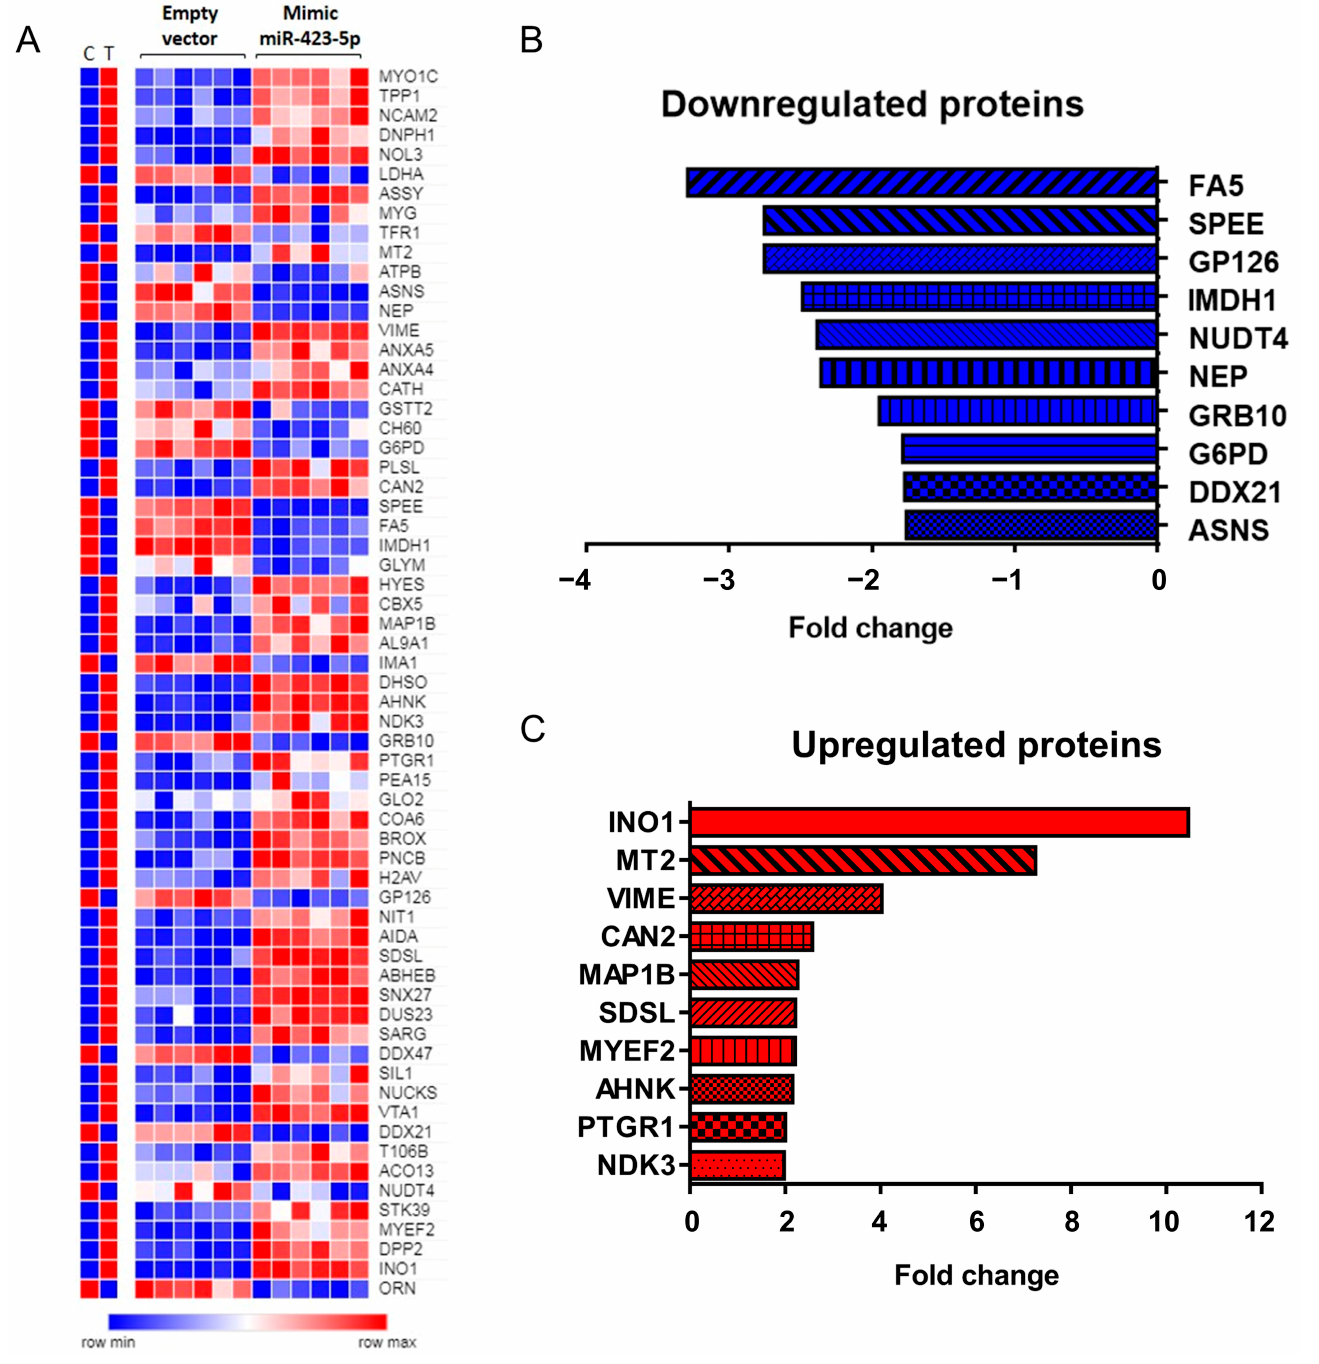
Figure 1. Differentially expressed proteins (DEPs) in LNCaP PCa cells expressing miR-423-5p mimic compared to control (empty vector) evaluated by quantitative SWATH-mass spectrometry and defined downregulated if fold change (FC) ≤ − 1.5, and upregulated if fold change (FC) ≥ 1.5. Data analysis performed with the SCIEX OneOmics cloud processing platform (n = 6 biological replicates, OneOmics confidence over 75%). ( A ) Heatmap representation of the average of proteomic data (C = ctr, empty vector; T = treated, mimic miR-423-5p) and heatmap of the individual replicates (empty vector and mimic miR-423-5p). ( B ) Histogram graph of the top ten downregulated proteins. ( C ) Histogram graph of the top ten upregulated proteins.